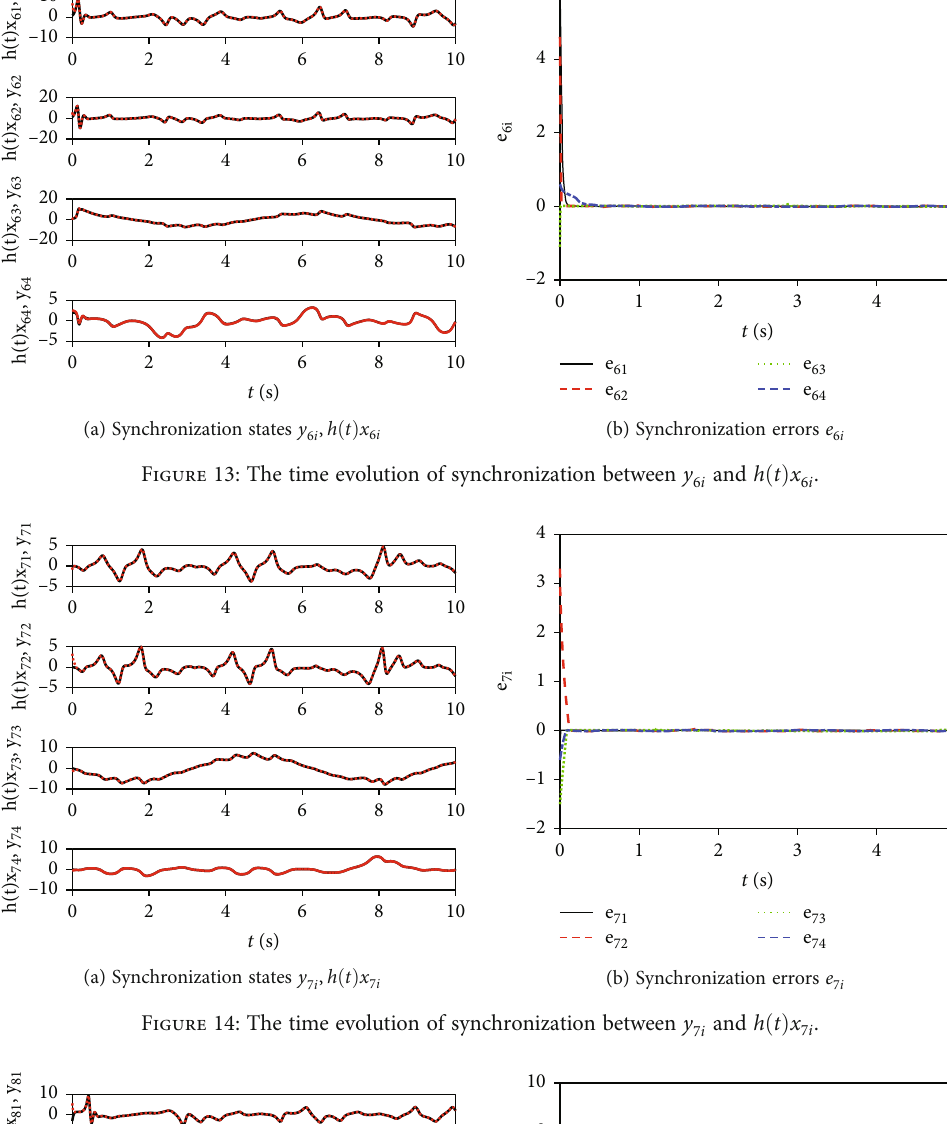
and h ð t Þ x 7 i 7 i